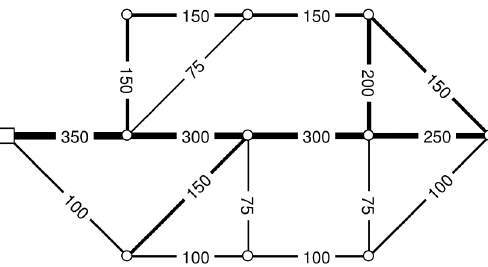
Figure 3. Fictitious example network, with pipe diameter labels.